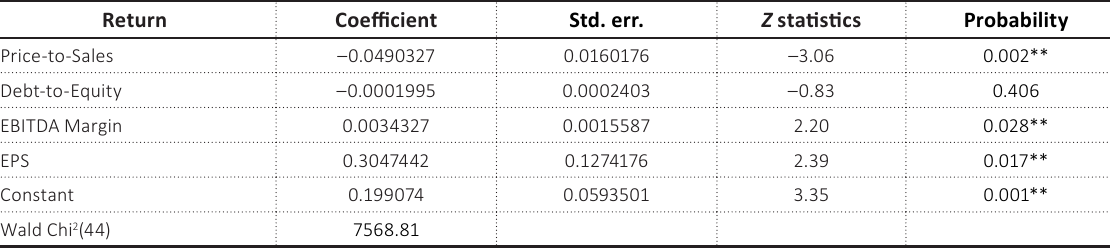
Table 14. Regression results using Parks-Kmenta estimator Return